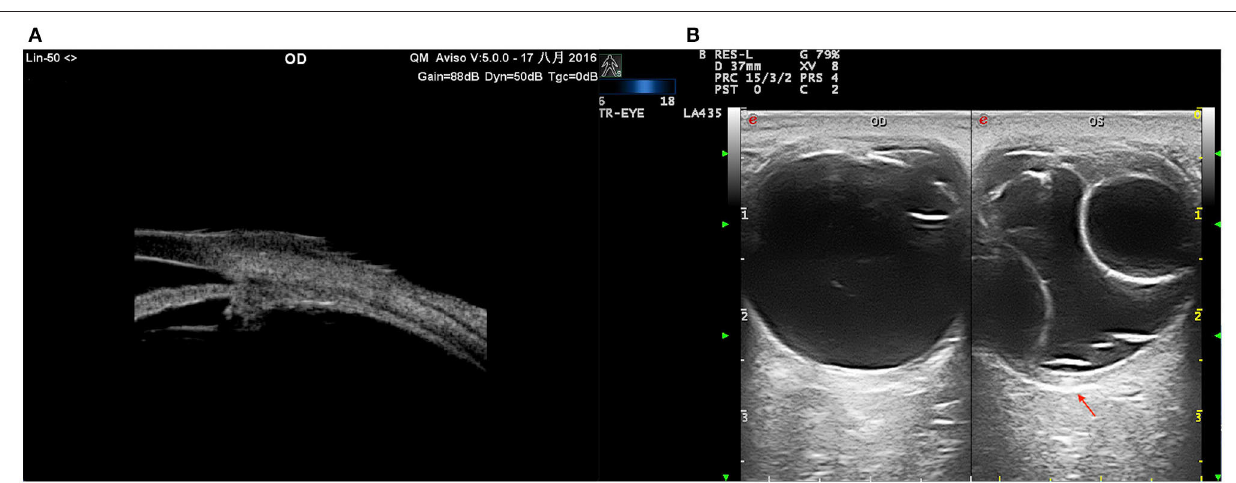
( Figure 7B ); in type 2, EDI-OCT was performed in 38 eyes of 19 patients; a choroidal thickness of 816.56 ± 10.21 µ m (range, 589.63–1075.61 µ m) was observed in the affected eye and 781.23 ± 9.33 µ m (range, 692.42–1104.15 µ m) in the fellow eye ( Figure 9 ). Both eyes of the same patient showed almost the same choroidal